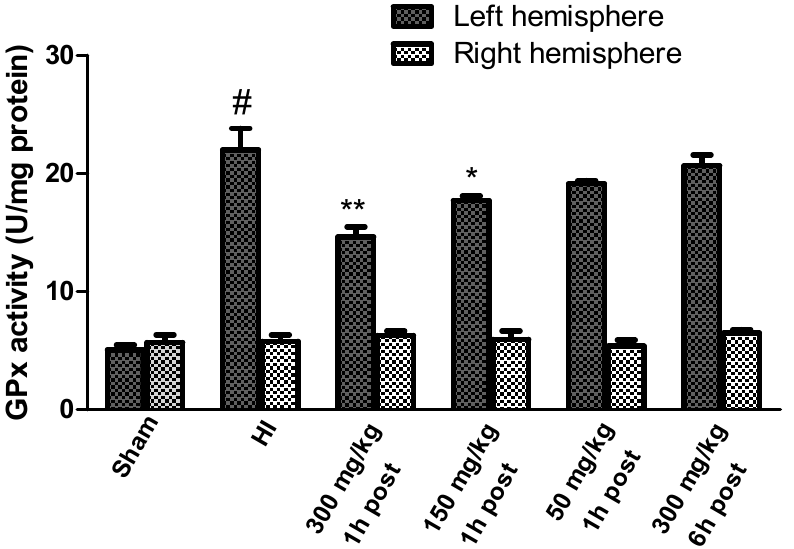
Figure 5. Effect of KYNA application on HI-induced changes in glutathione peroxidase activity. The results are presented as the means ± SEM, n = 6–7; statistically significant differences: * p < 0.05, ** p < 0.01 compared to the HI group; # p < 0.001 compared to the sham-operated group.